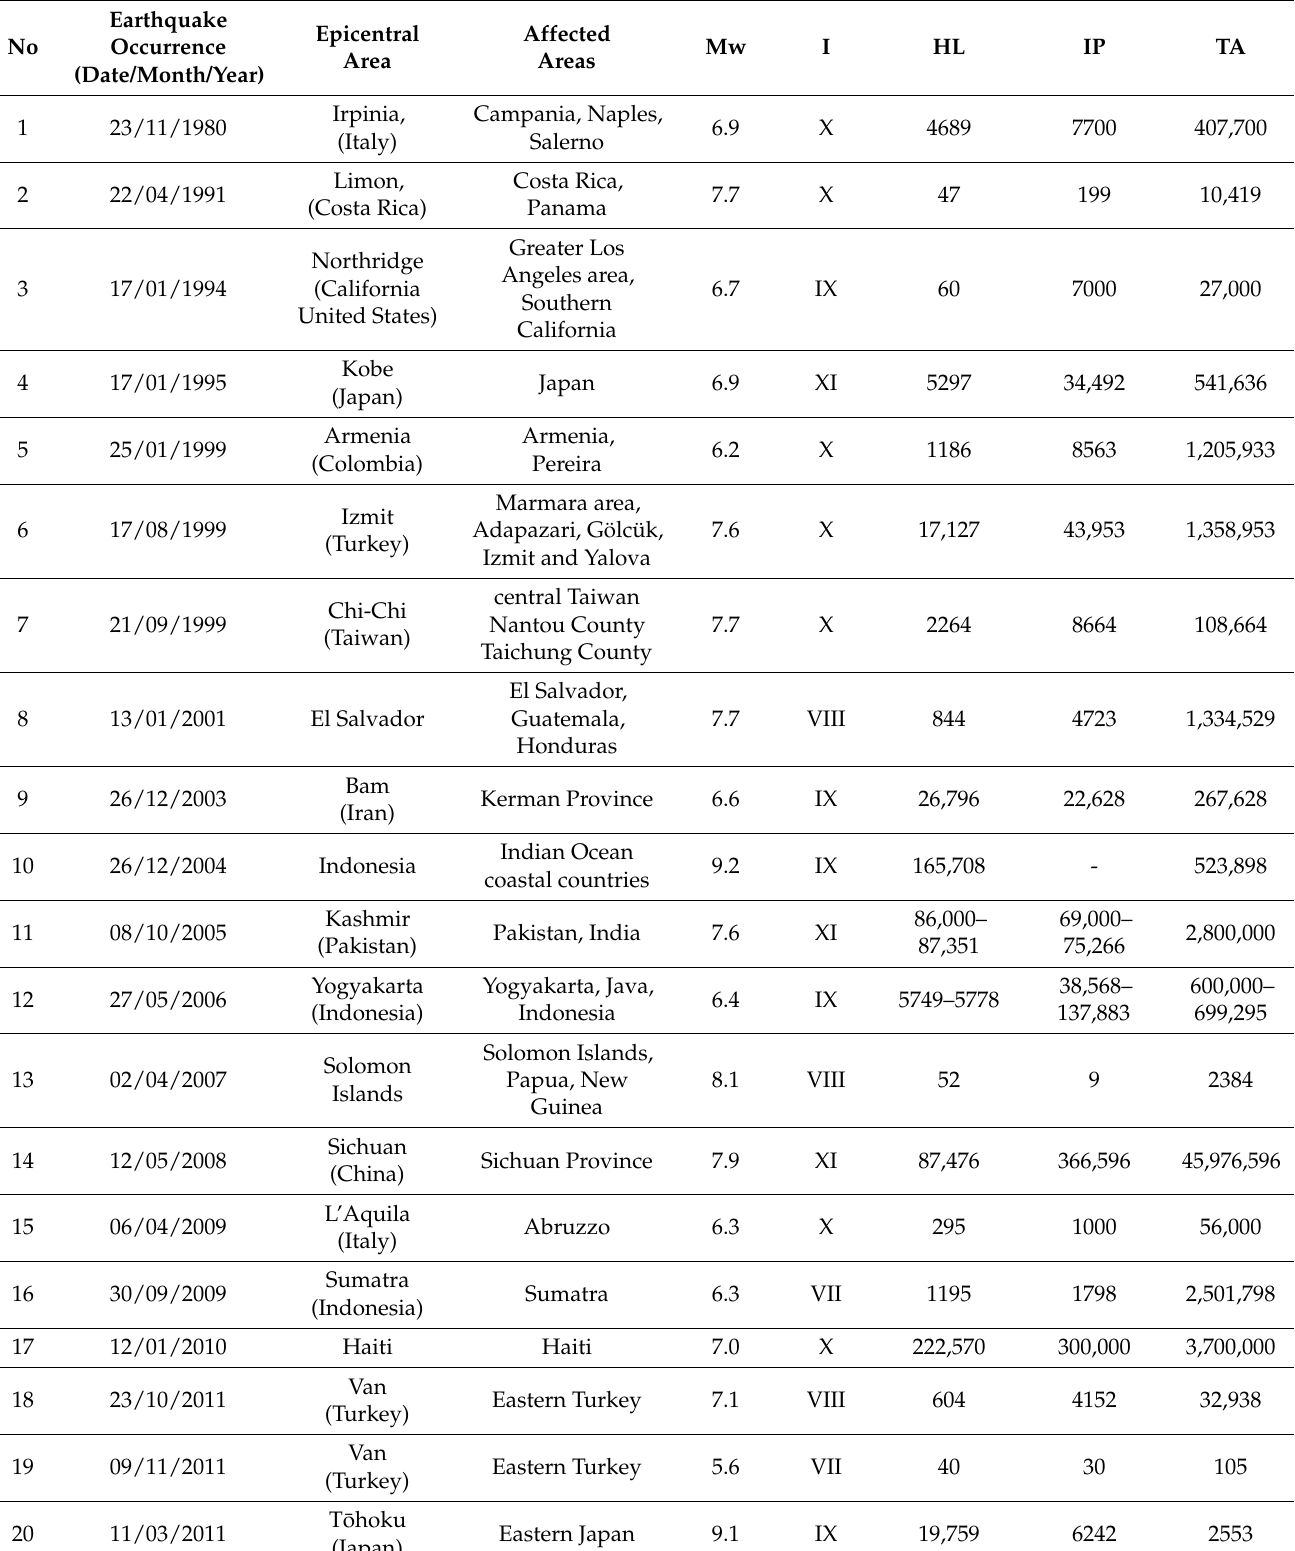
Table 1. Parameters and impact of earthquakes generated within a time period spanning from 1980 to 2016 that induced infectious diseases and public health risks (Mw: moment magnitude, I: Intensity, HL: Human losses, IP: Injured people, TA: Total affected people). Information about Mw, I, HL, IP, and TA are extracted from the International Disaster Database EM-DAT